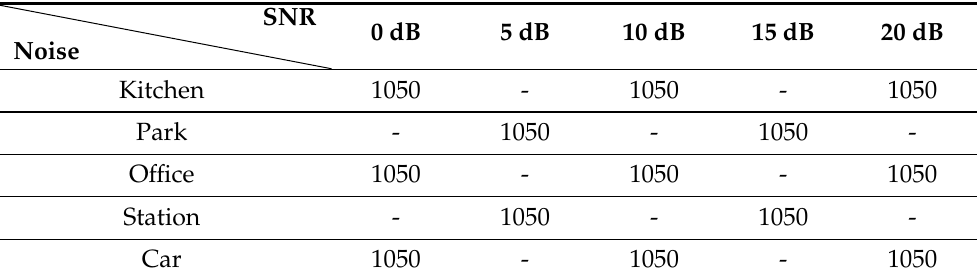
Table 2. In the visual modality, we train our VSR models using not only phrase data but also digit sequence data based on our previous work [31]. Table 2. The amount of acoustically noisy data for ASR training: e.g., 1050 = 35 (speakers) 10 (utterances) 3 (times). ×